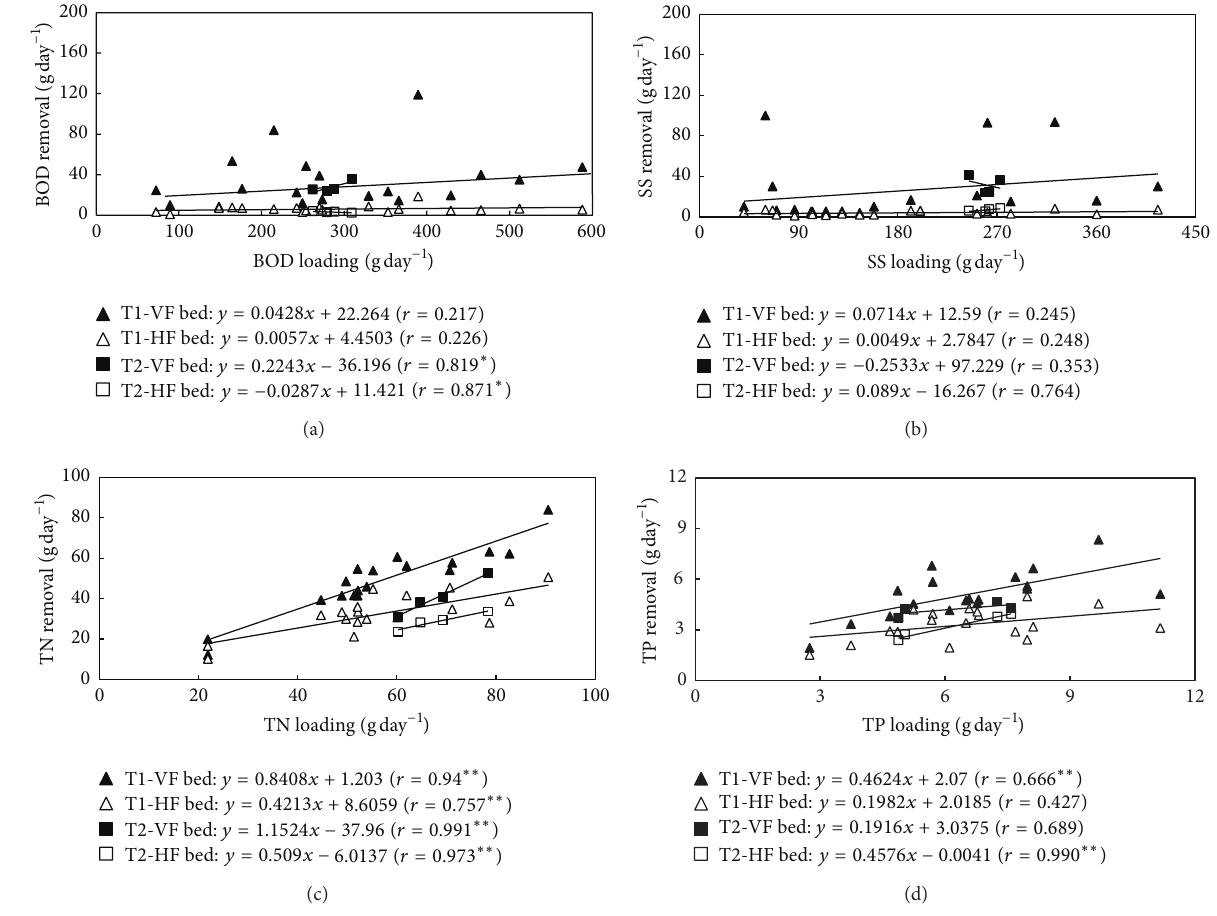
Figure7: Relationship between BOD, SS, TN,and TPloading andremoval inaVF-HF hybridconstructed wetland underdifferent ventilation methods (Treatment1 (T1): VF-HF CWs with natural ventilation; Treatment2 (T2): VF-HF CWs with ventilation using an electric air fan